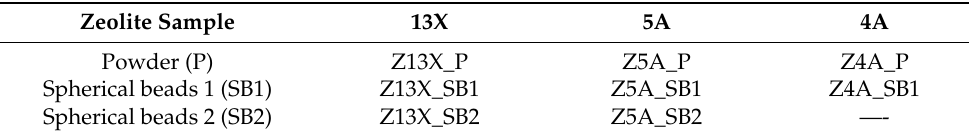
Table 1. Zeolite samples studied in this